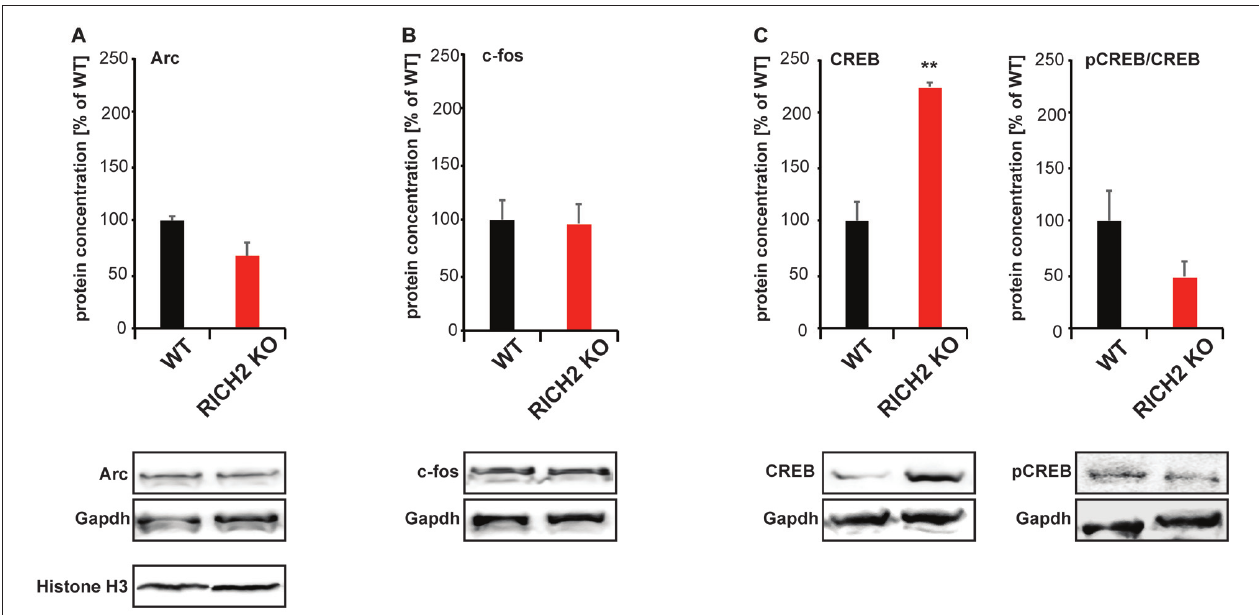
FIGURE 7 | Immediate early gene (IEG) expression in RICH2 KO mice. IEG expression was analyzed in nuclear protein lysate from amygdala and normalized to GAPDH levels. No significant difference was detected in the expression of (A) activity-regulated cytoskeleton-associated protein (ARC; Unpaired t -test, n = 3, p = 0.077), and (B) c-FOS (Unpaired t -test, n = 3, p = 0.8784). A significant difference was detected in the expression of (C) cyclic AMP response element-binding protein (CREB; Unpaired t -test, n = 3, p = 0.002). The amount of phosphorylated CREB (pCREB) was unchanged (Unpaired t -test, n = 3, p = 0.1822). Exemplary Western blot bands are shown. Histone H3 was used a control for the presence of nuclear proteins in the